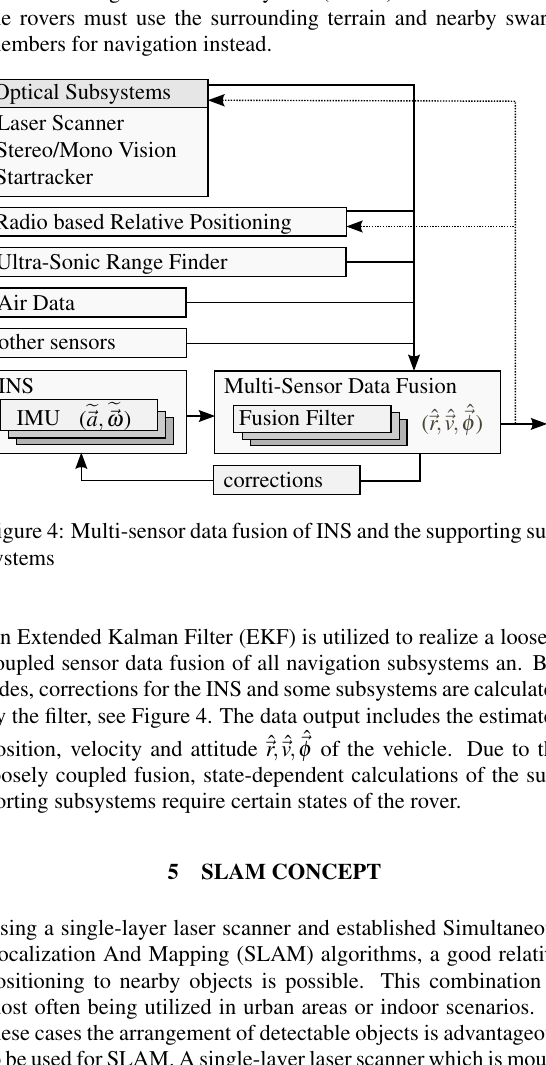
Figure 5: Vertical construction of the laser scanner of the UAV